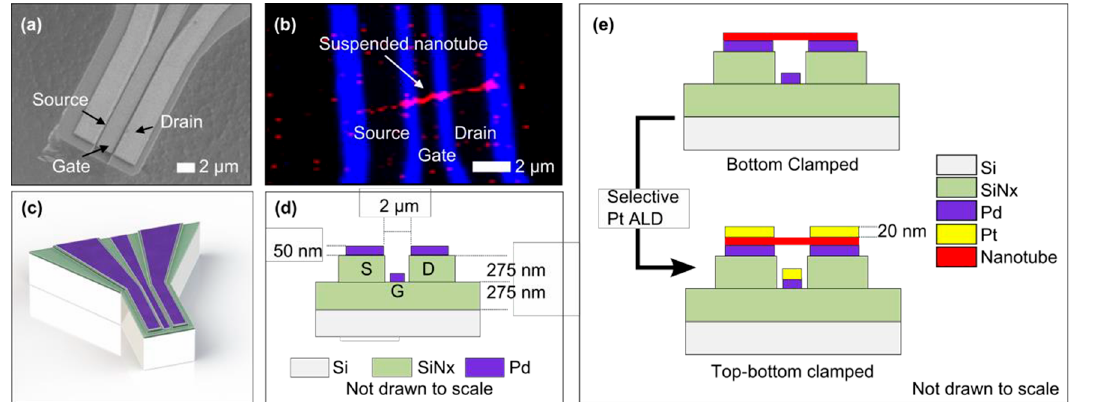
Figure 1. ( a ) Scanning electron microscope (SEM) image representing a FET based device with bottom gate electrode; ( b ) Raman image of suspended carbon nanotube (red) resonator device obtained after dry transfer; ( c , d ) Schematic of device and it’s cross-section; ( e ) Schematic of two different clamping geometries with the same nanotube device investigated in this work.